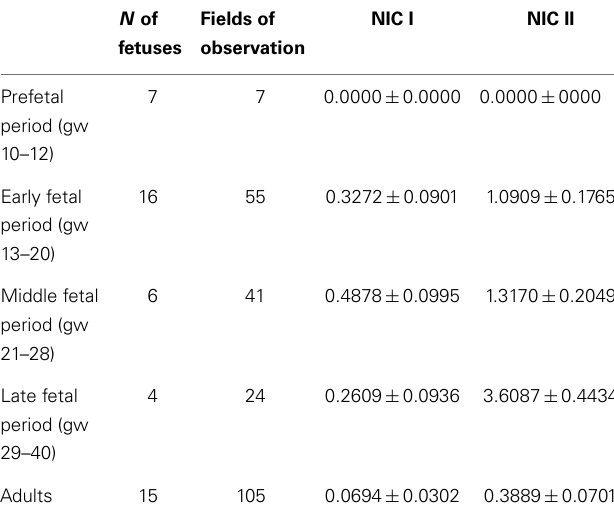
Table 3 | Number of neuro-insular complexes during various stages of human development (mean ±